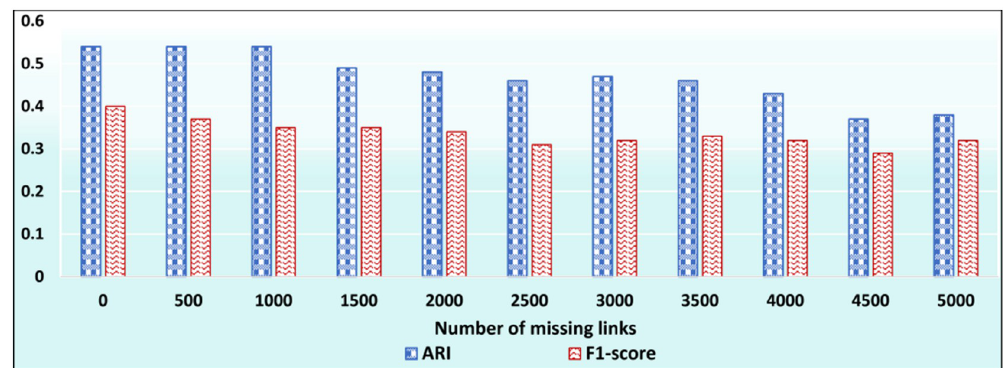
Fig 33. The accuracy of ID_CC in detecting the Friendster communities after identifying and reinstating missing Association Edges.